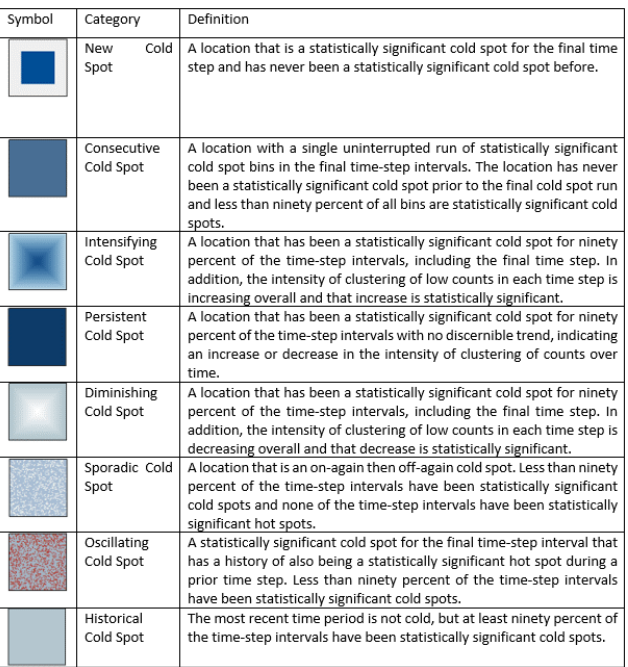
Figure A7. Hotspot categories.